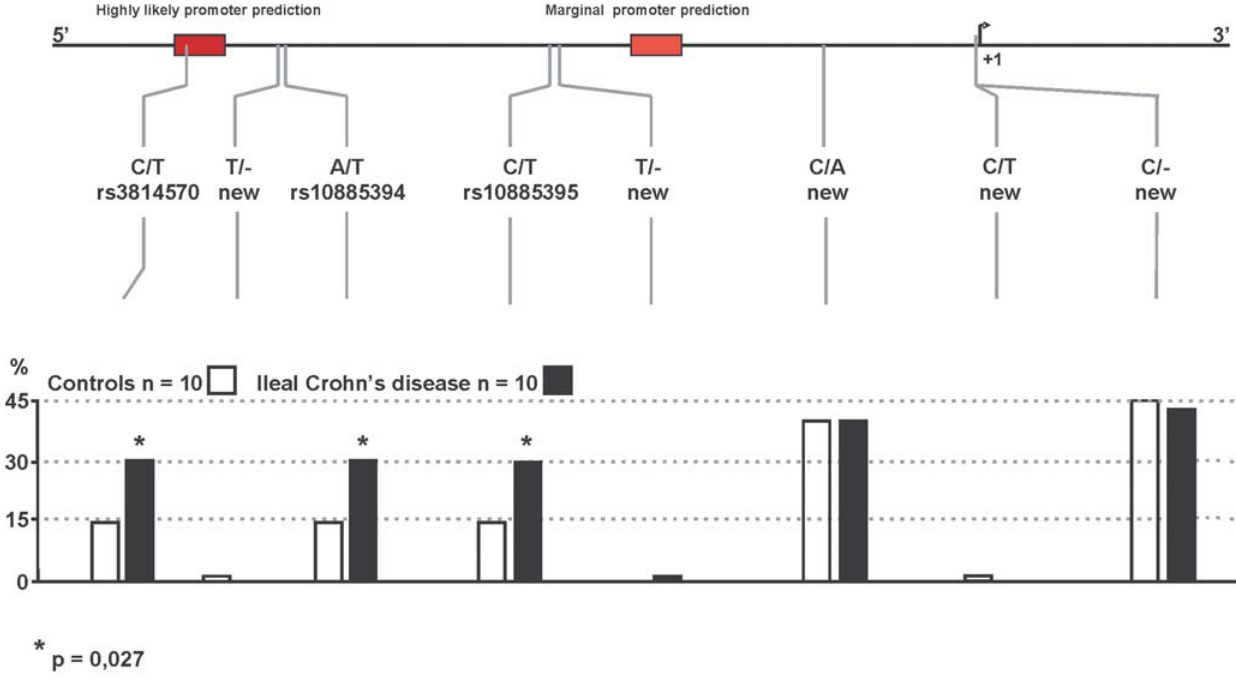
Figure 1. Sequencing of TCF-4 ( TCF7L2 ) 5 9 upstream putative promoter region. Sequencing of a 2.1 kb upstream region was performed in 10 healthy controls and 10 patients with ileal Crohn’s disease. Putative regulatory regions were determined using promoter prediction software. Likely and marginal prediction sites are depicted as red boxes (upper panel). Relative location of identified variants is marked via grey dashes (upper part) and their allele frequency is demonstrated via bars for controls as well as patients (lower part).